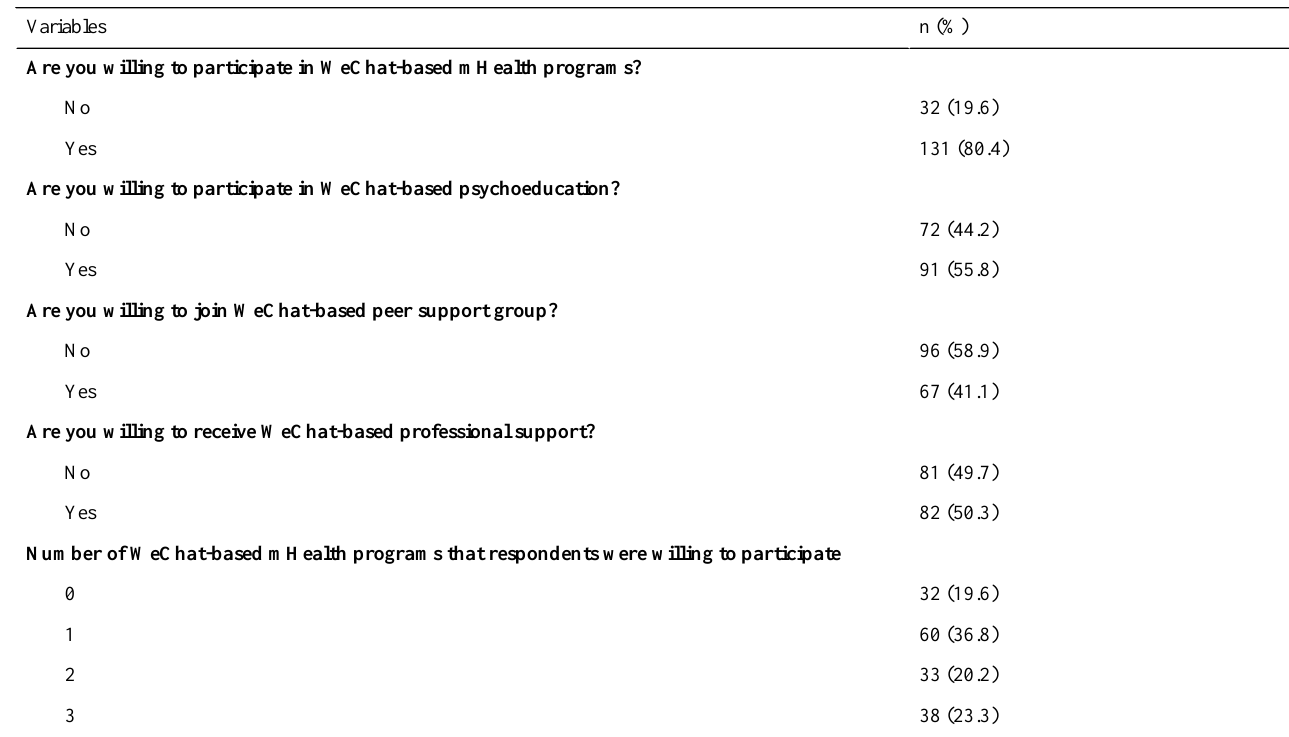
Table 2. Endorsement of WeChat-based mHealth programs (N=163).